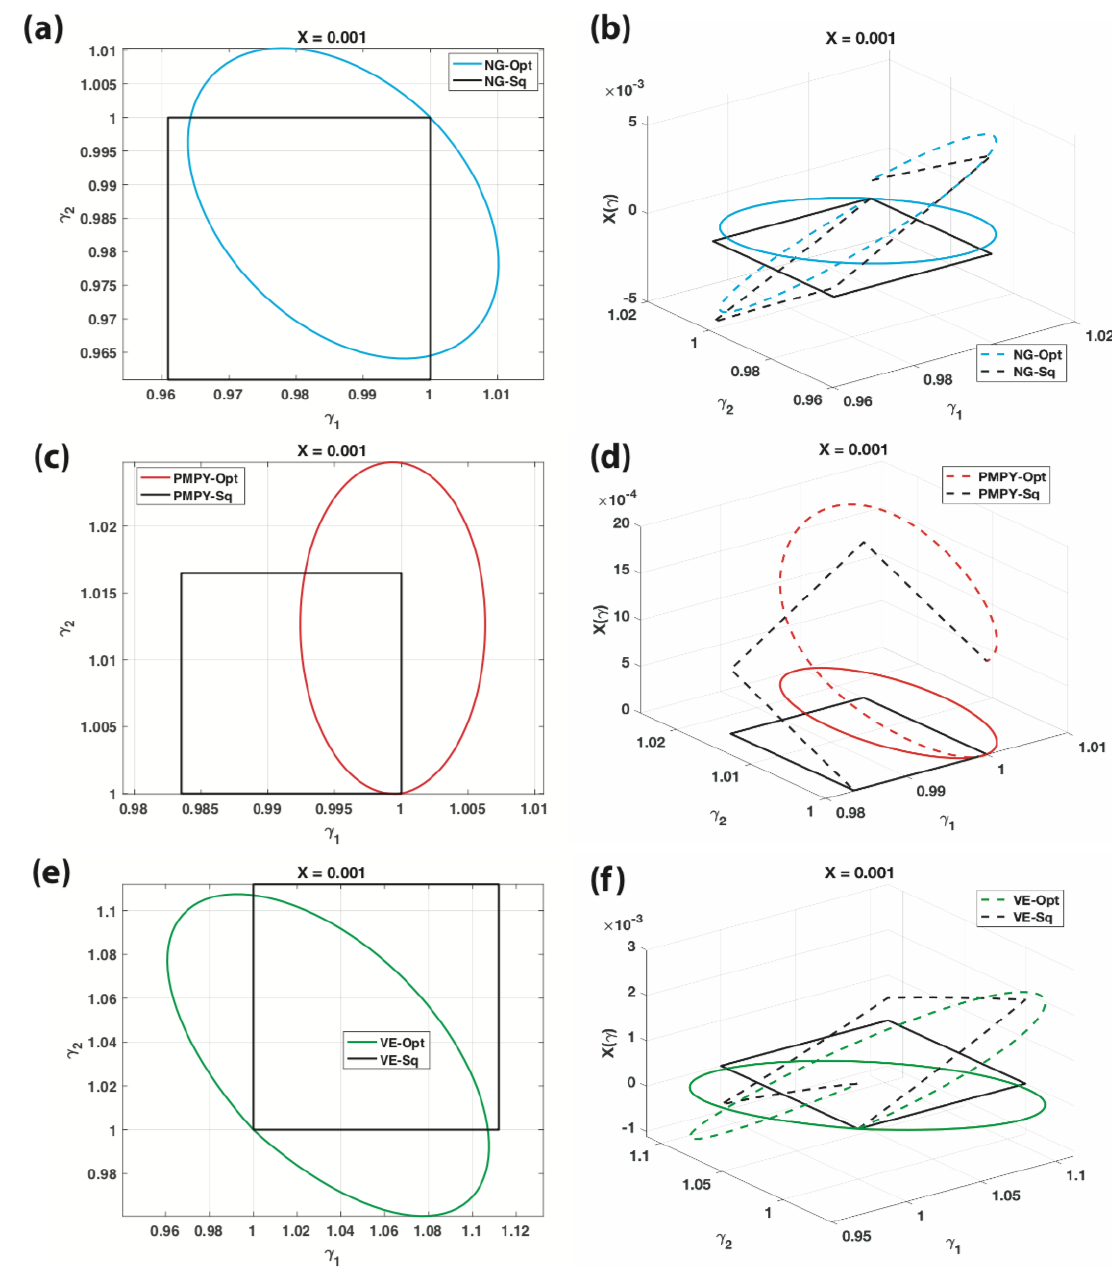
Figure A3. Comparison between optimal and square strokes of NG 3-sphere, PMPY 2-sphere and VE 3-sphere swimmers. ( a , c , e ) give the γ -paths of the optimal strokes ( γ ) and the square strokes ( γ sq ) of the NG, PMPY and VE swimmers, all with X ( γ ) = 0.001 and ε = 0.2. ( b , d , f ) give the stroke trajectories X ( γ ( t )) , t ∈ [ 0,1 ] (dashed lines) corresponding to the γ -paths (solid